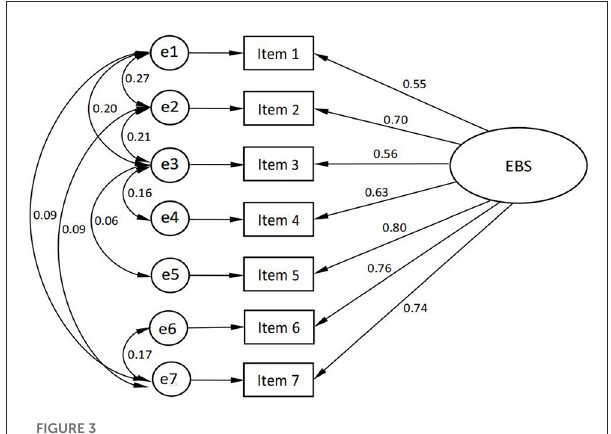
FIGURE3 The validation factor analysis model for the Chinese version of the EBS short